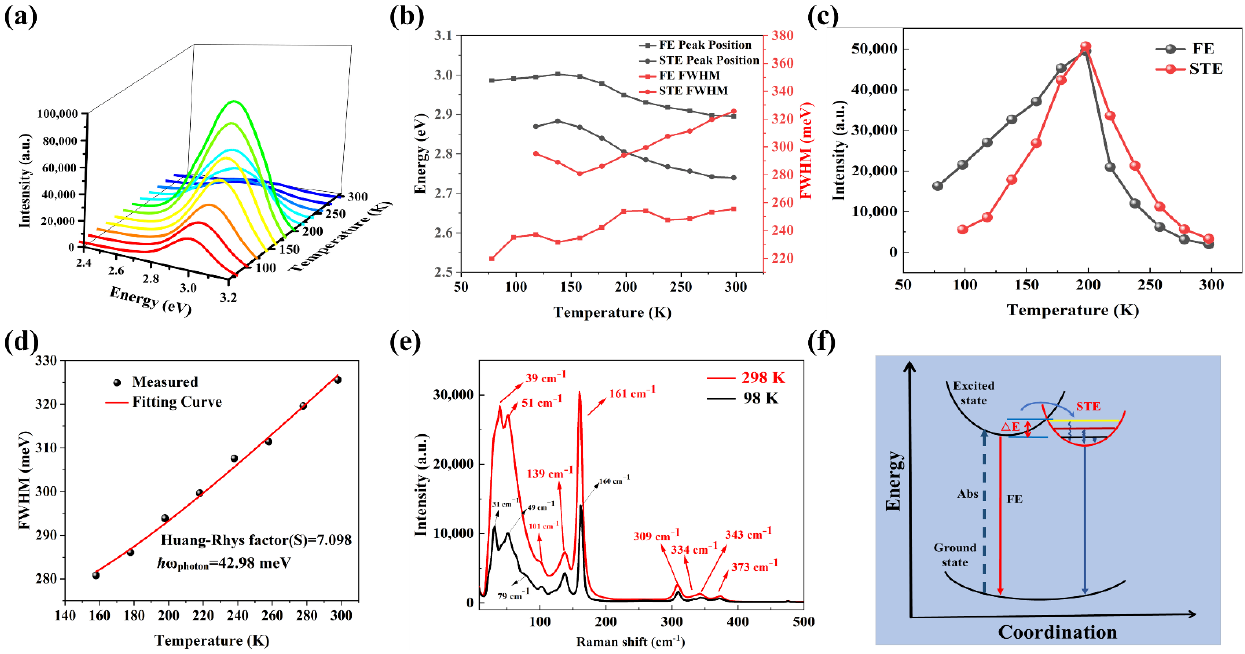
Figure 4. ( a ) Relationship between emission spectra and temperature of (TPA) 2 PbBr 4 . ( b ) Peak position; FWHM versus temperature. ( c ) PL intensity versus temperature. ( d ) FWHM obtained from PL spectra versus temperature. ( e ) The Raman spectra of (TPA) 2 PbBr 4 SC at 298 K and 98 K, respectively. ( f ) Possible photophysical process of (TPA) 2 PbBr 4 .